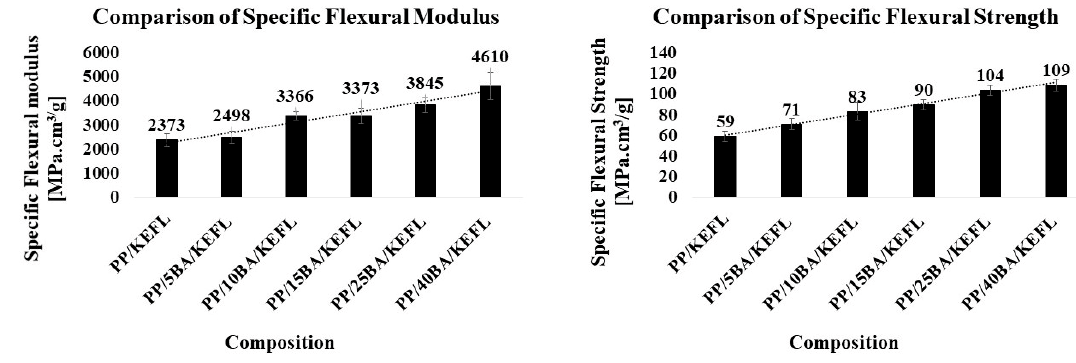
Figure 3. Flexural analysis of composites with bast and hybrid bast/BA fibers.